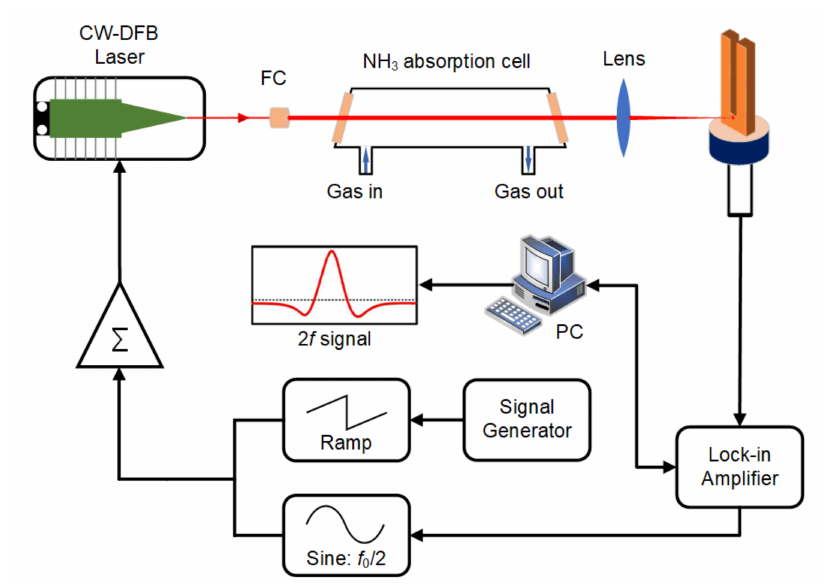
Figure 3. Schematic diagram of the LITES sensor system.